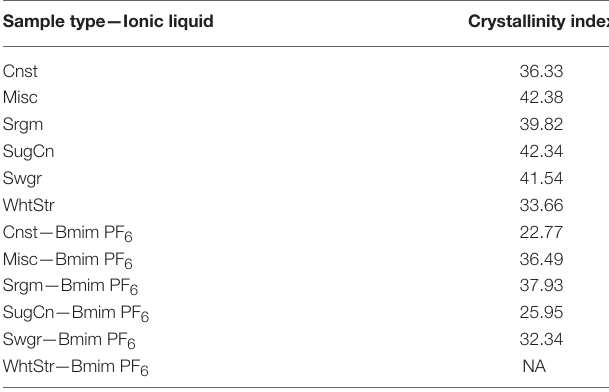
TABLE 3 | Crystallinity Index of herbaceous biomass types that are either untreated, or treated with Bmim PF 6 . Sample type—Ionic